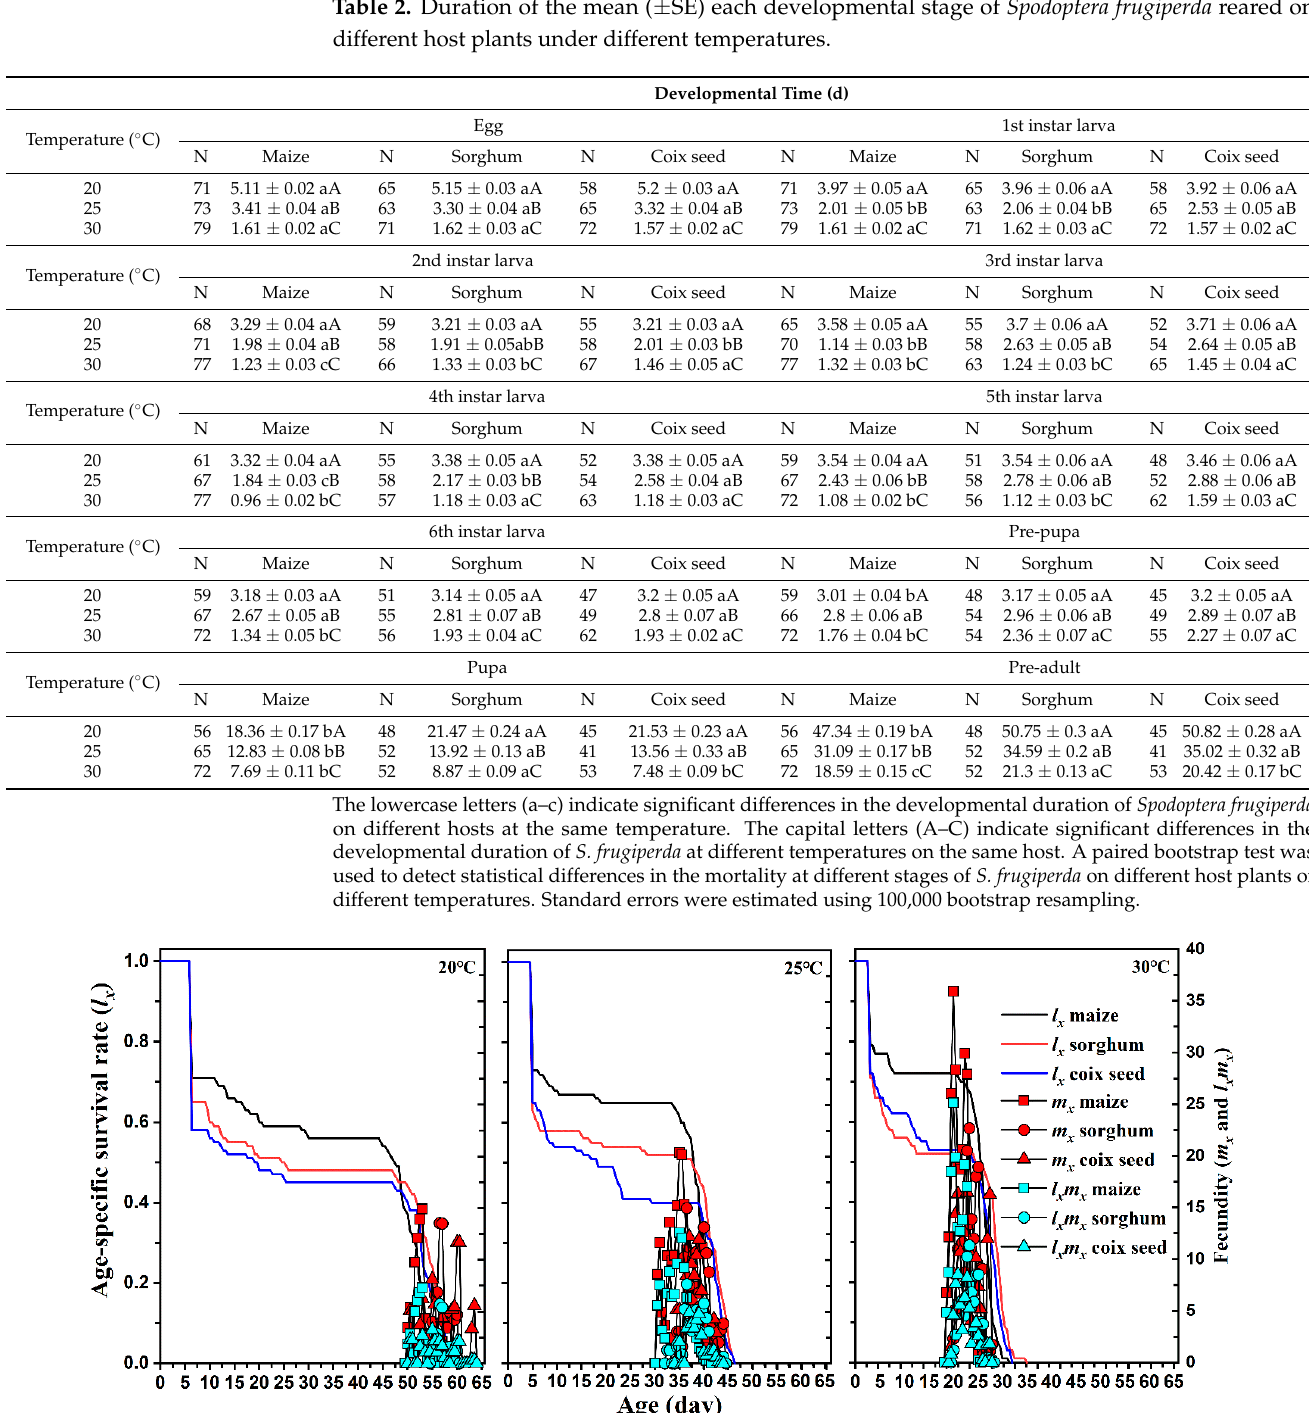
Figure 2. Age-stage specific survival rate ( l x ), fecundity ( m x ), and maternity ( l x m x ) of Spodoptera frugiperda on different hosts and at different temperatures.